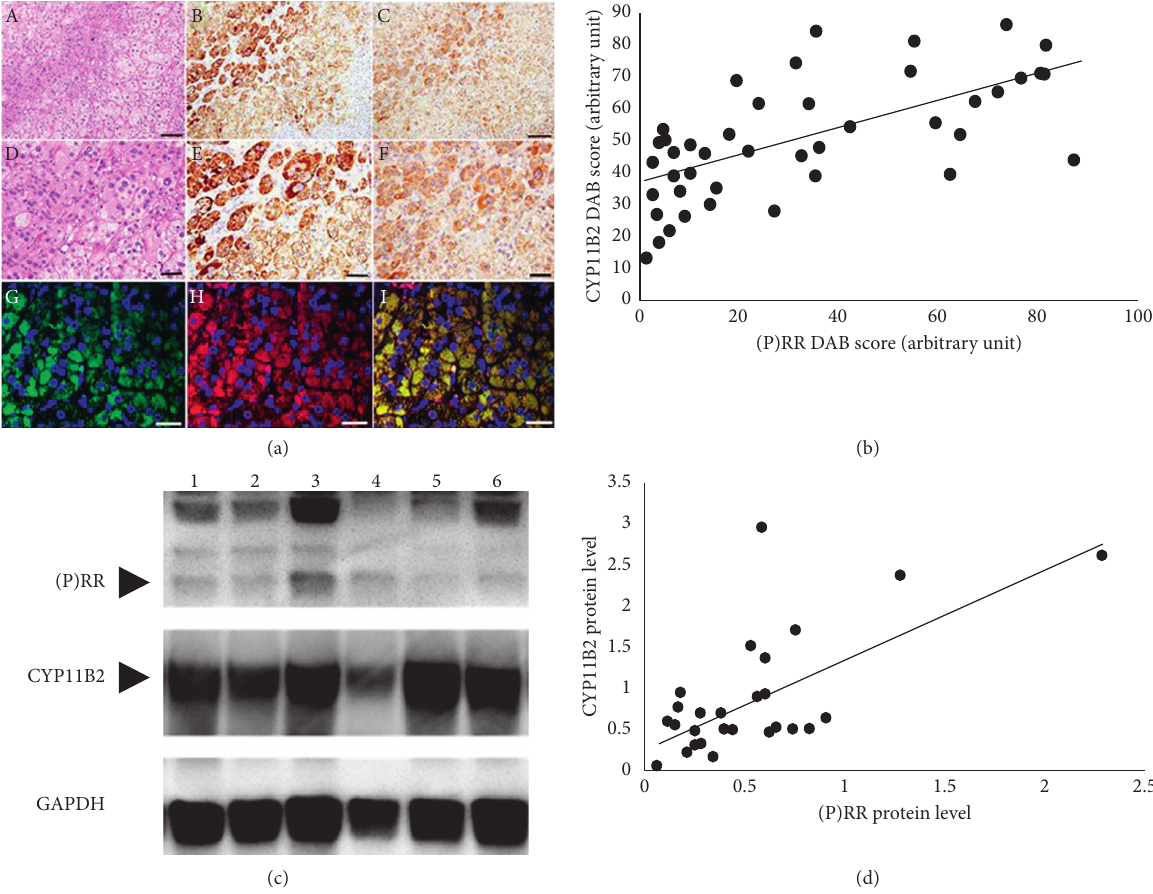
Figure 1: (a) Histological findings in aldosterone-producing adenoma. A and D: hematoxylin and eosin staining; B and E: immuno- histochemical staining for CYP11B2; C and F: immunohistochemical staining for (P)RR; G: immunofluorescent staining for CYP11B2 (green) and DAPI (blue); H: immunofluorescent staining for (P)RR (red) and DAPI (blue); and I: immunofluorescence-merged images showing dual-labeled CYP11B2 and (P)RR (yellow) and DAPI (blue). Bar lengths: (A–C) 100 μ m; (D–F) 50 μ m; and (G–I) 20 μ m. (P)RR: (pro)renin receptor and DAPI: 4 ′ ,6-diamidino-2-phenylindole. (b) Scatter plots showing the positive association between adrenal (P)RR and CYP11B2 expression. (c) Western blot analysis in aldosterone-producing adenoma. The intensity of bands for (P)RR and CYP11B2 is shown in each lane (depicted by a black arrow). The other bands are nonspecific bands. (d) Scatter plots showing the positive association between adrenal (P)RR and CYP11B2 protein levels measured by Western blotting results. (P)RR: (pro)renin receptor and GAPDH: glyceraldehyde 3-phosphate dehydrogenase.